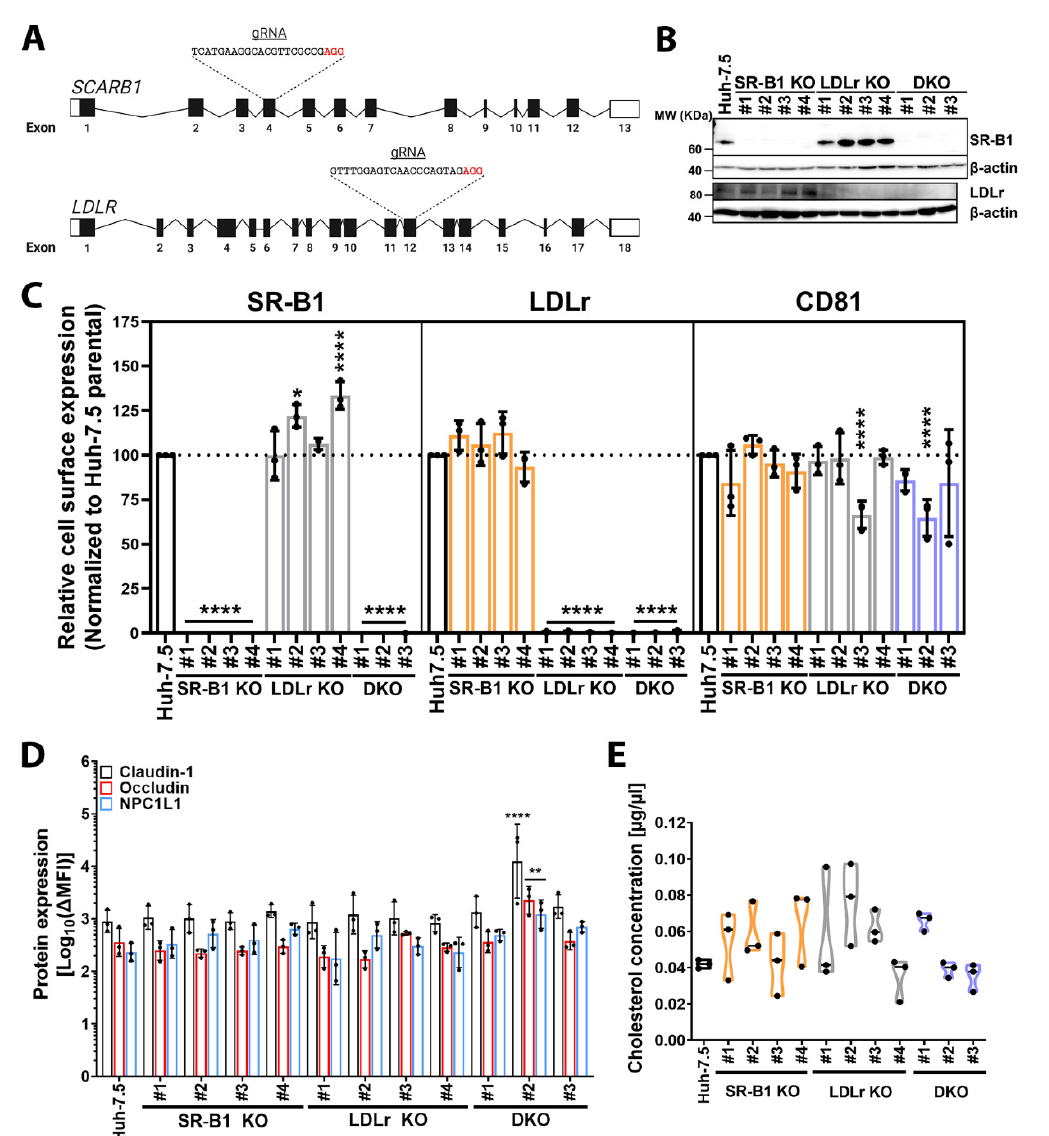
Figure 3. Characterization of lipoprotein receptor-deficient cell lines. Lipoprotein receptor knock-out (KO) strategy and characterization. Lipoprotein receptor SCARB1 (SR-B1) and LDLR (LDLr) gene scheme ( A ). Graphic representation of genes for SR-B1 and LDLr. Exons are shown as boxes with black areas representing open reading frames (ORFs). Introns are shown as lines. CRISPR-Cas9 guide RNA (gRNA) nucleotide sequence targeting SCARB1 and LDLR are depicted. Protospacer adjacent motif (PAM) is highlighted in red. Image created with BioRender.com (accessed 09/04/2020). Endogenous expression of lipoprotein receptors SR-B1 and LDLr ( B ). Cell lysates were evaluated for expression of indicated proteins by immunoblot using abs against the specific targets. β -actin was used as an internal control (42 kDa). Cell surface expression of SR-B1, LDLr, and CD81 in SR-B1 KO clones (light orange bars), LDLr KO clones (grey bars), and DKO clones (light blue bars) ( C ). Saturating concentrations of fluorophore conjugates abs against cellular targets and their isotype controls were used to stain cells for 20 min at 4 °C. Stained cells were analyzed by flow cytometry and Δ MFI was calculated as stated in the methods. Δ MFI values were normalized to parental Huh-7.5 cells. Endogenous expression of HCV entry factors claudin-1, occludin, and NPC1L1 ( D ) . Protein expression was determined by immunostaining of permeabilized cells with equal amounts of specific abs or isotype controls for 60 min at 4 °C, followed by detection of bound abs with an Alexa Fluor 488 (AF488)-conjugated secondary ab. Specific staining was determined as Δ MFI. Total cholesterol in lipopro- tein receptor KOs ( E ). Lipids were extracted from cells as described in the methods. The cholesterol fraction was measured using a colorimetric assay and cholesterol amount extrapolated from an in-run standard curve and transformed to choles- terol concentration (µg/µL). KO cells are shown in the same color patterns as for C. Graphs C, D, and E display the average of three experiments performed in triplicate and represent individual values as black dots. SD is shown as error bars. Statistical significance of the total ( D ) or cell surface staining ( C ) was assessed by a two-way ANOVA with a Dunnett post